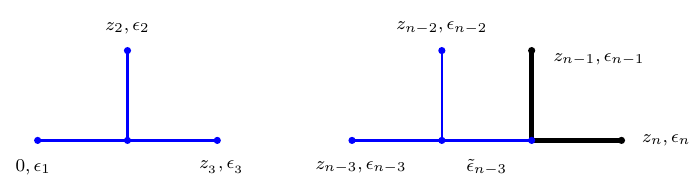
Figure 7 . i -th identity block: ˜ ✏ i = 0, the zeroth channel is shown in red.